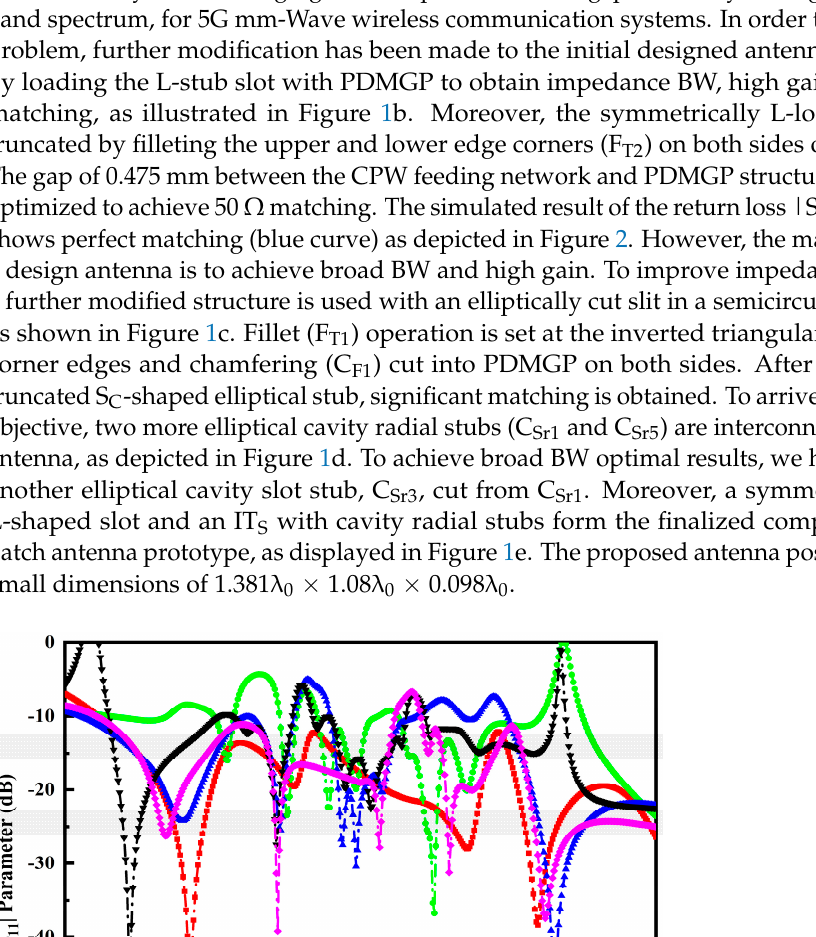
Table 1. Proposed antenna variables and optimized values (unit: mm).